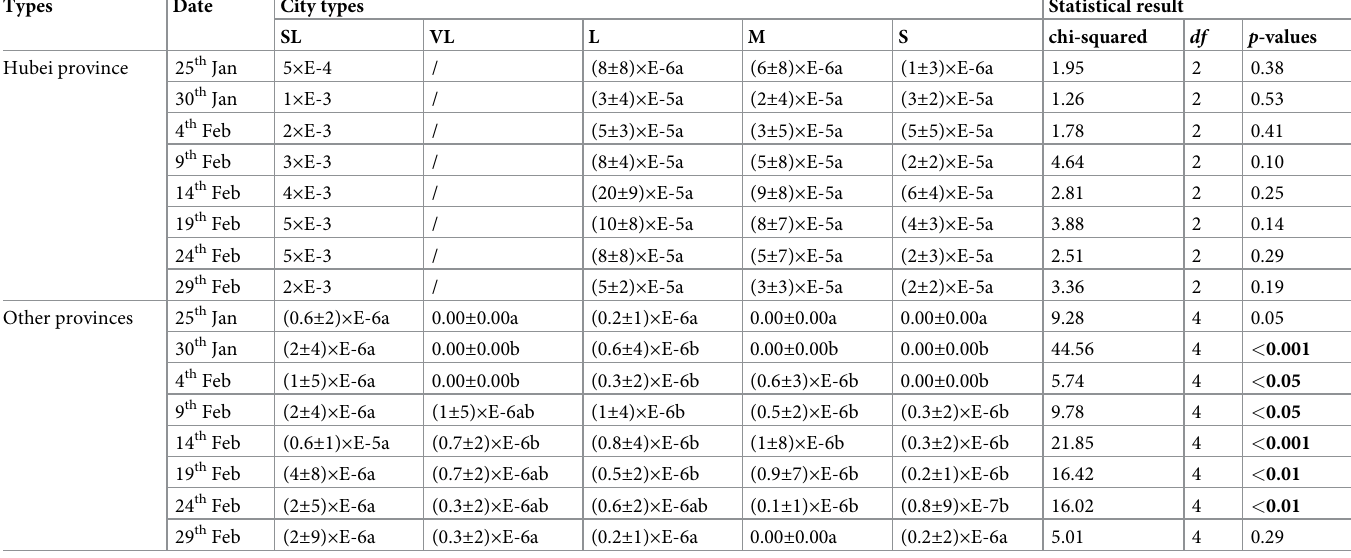
Table 3. Differences in deaths over population size per 100000 at every 5 consecutive days (DOPSPTT) among five types of cities outside and in Hubei province from 25th January to 29th February,